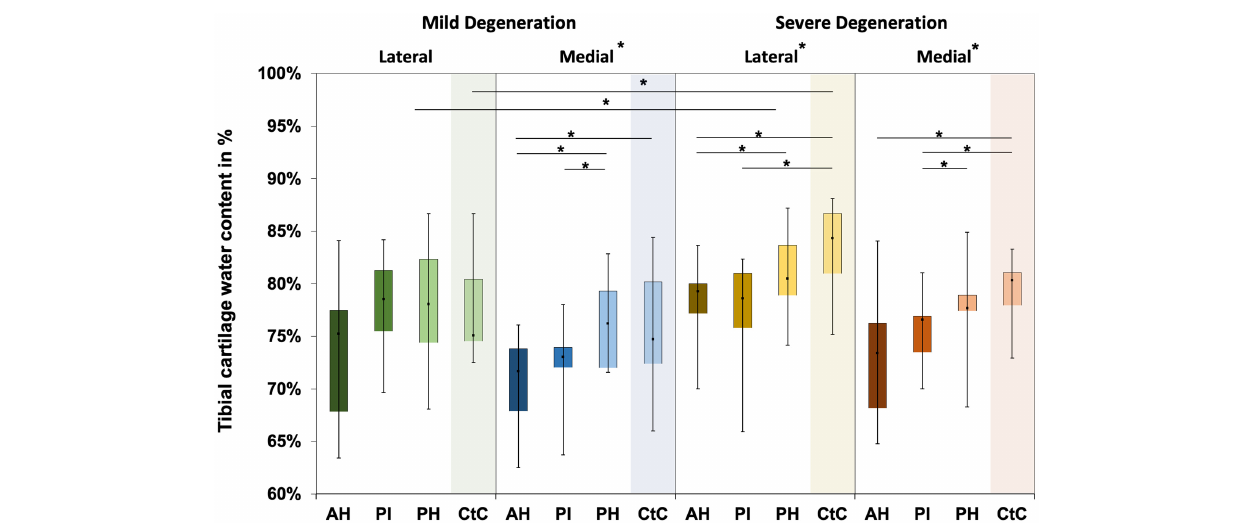
FIGURE 7 | Water content in percent of the mildly and severely degenerated tibial plateau articular cartilage (AC). Box plots (minimum, maximum, median, and 25th and 75th percentiles) of the tibial cartilage water content values in percent. Subdivided anatomical regions are: AH, anterior horn; PI, pars intermedia; PH, posterior horn; CtC, cartilage-to-cartilage contact area. Non-parametric statistical analyses: n = 12; * p < 0.05.